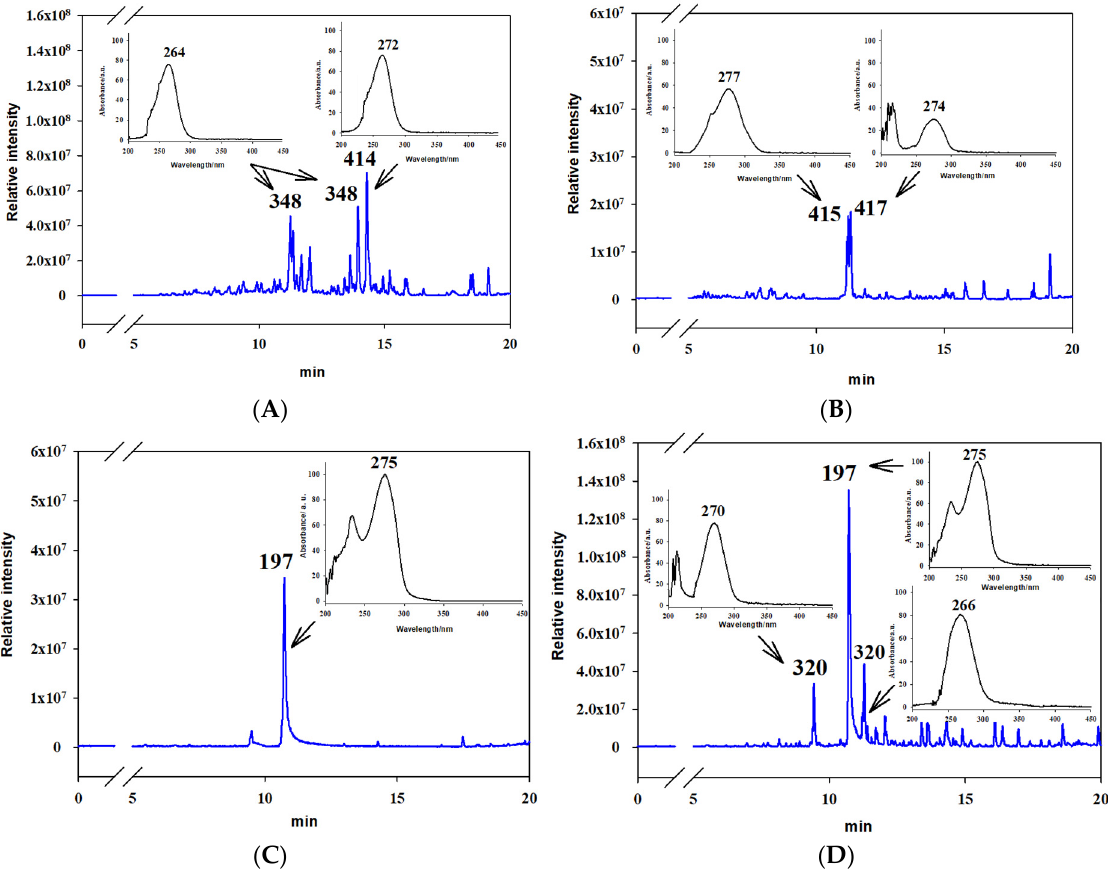
Figure 6. Representative HPLC/MS chromatograms of extracts showing entomotoxic activity from Alternaria tenuissima MFP253011 cultures on various media obtained with dichloromethane ( A ) M1D medium, ( B ) Sabouraud medium and ethyl acetate, ( С ) YMG medium, and ( D ) pearl barley.